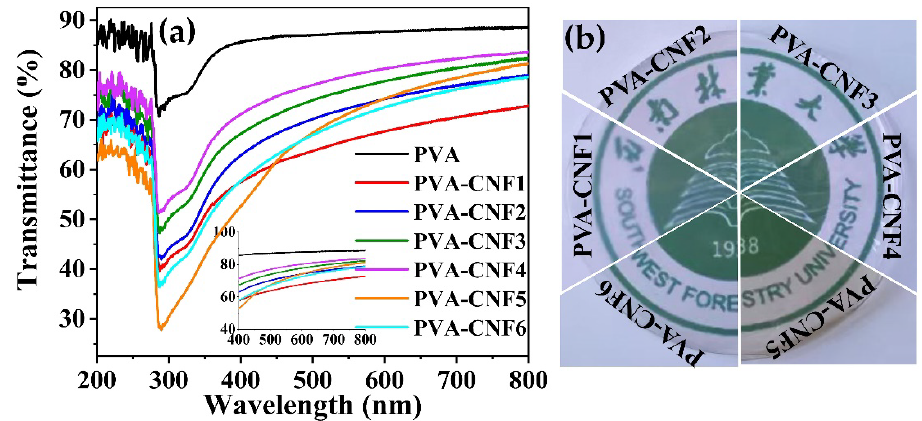
Figure 2. Transmittance of the pure PVA and composite films ( a ): transmittance of films; ( b ): visibility of films.